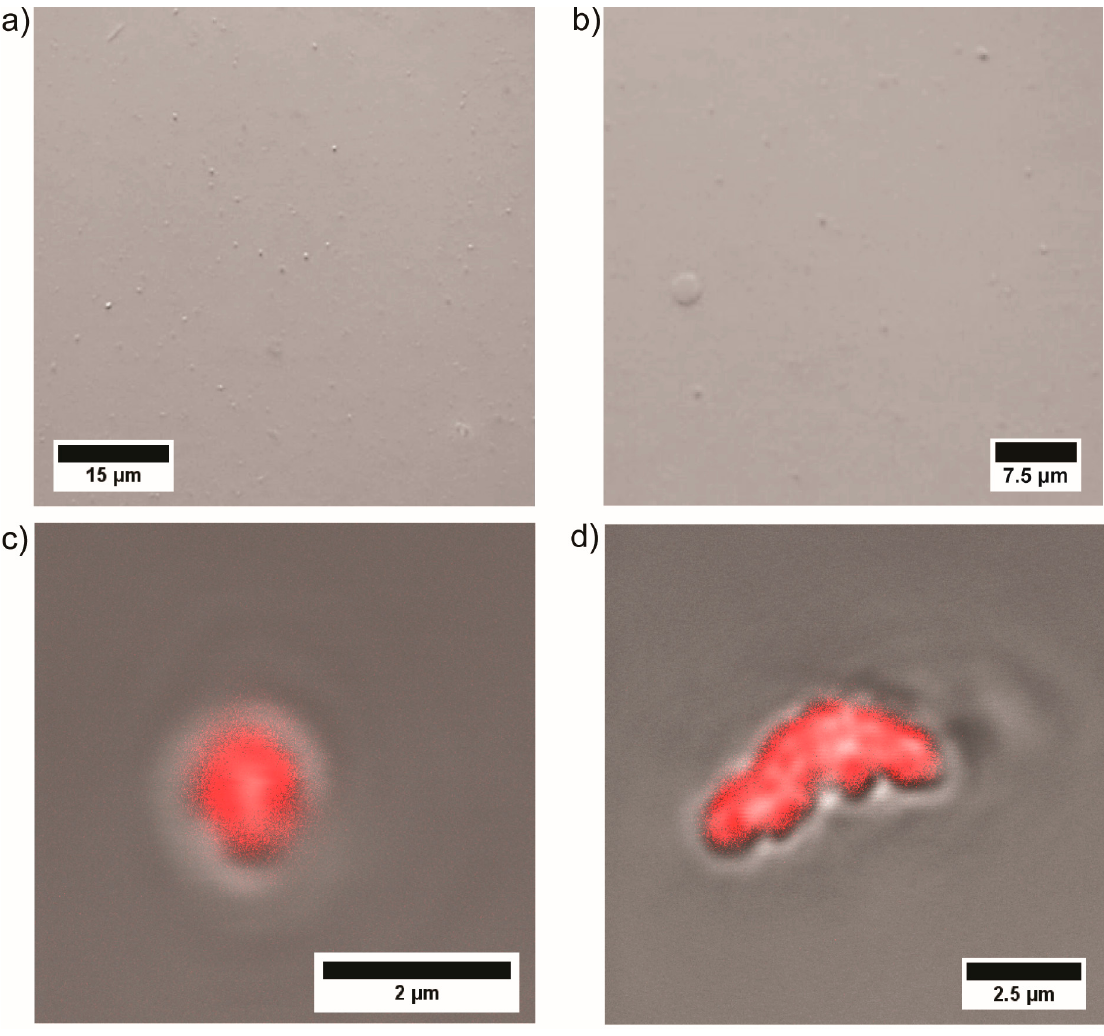
Figure 3. ( a , b ) optical microscopy images of PEtOx 22k - b -PVP 14k at a concentration of 20 wt % in water at 25 °C and ( c , d ) overlay of LSCM/DIC images from PEtOx 22k - b -PVP 14k at a concentration of 2.5 wt % in water stained with Rhodamine B at 25 °C.